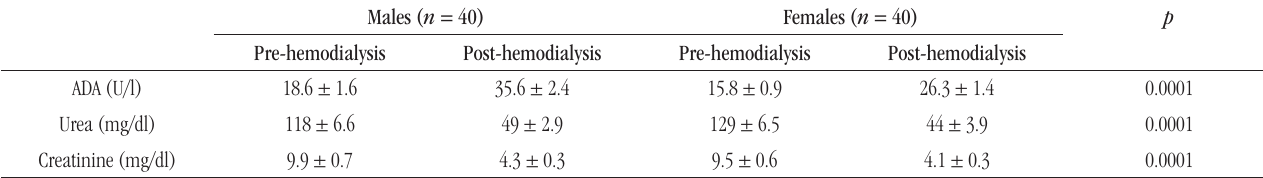
taBLE 2 − Comparison of laboratory analyses in pre- and post-hemodialysis periods between male and female patients Males ( n = 40) Females ( n = 40) p Pre-hemodialysis Post-hemodialysis Pre-hemodialysis Post-hemodialysis ADA (U/l)